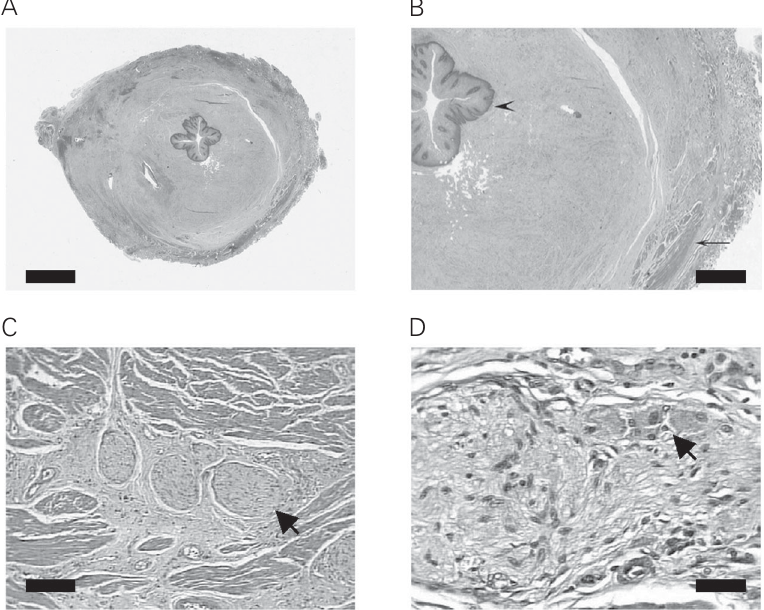
Figure 2. Histological analysis of the esophagus from a patient submitted to esophageal replacement. A , Esophagus showing stenosis of the lumen and extensive fibrosis that compromised the mucosa, submucosa and partially the muscular layer (HE 10X, bar = 1650 µm). B , Detail of A . Extensive fibrosis replacing almost all the normal components of the esophageal wall from the epithelium (arrowhead) to the external muscular layer (arrow; HE 32X, bar = 484 µm). C and D , Details of A . Note the preserved myenteric plexus (arrow; HE 132X, bar = 200 µm and 330X, bar = 50